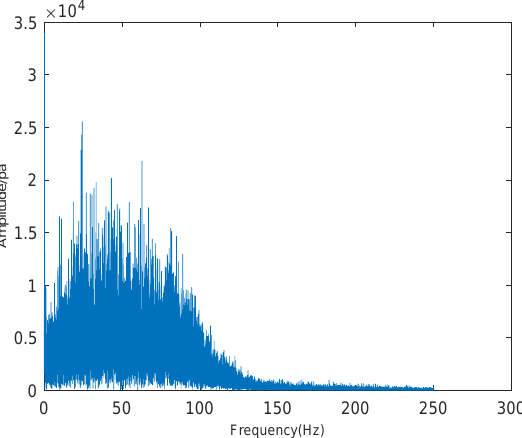
Figure 12. Frequency-domain sound signal.